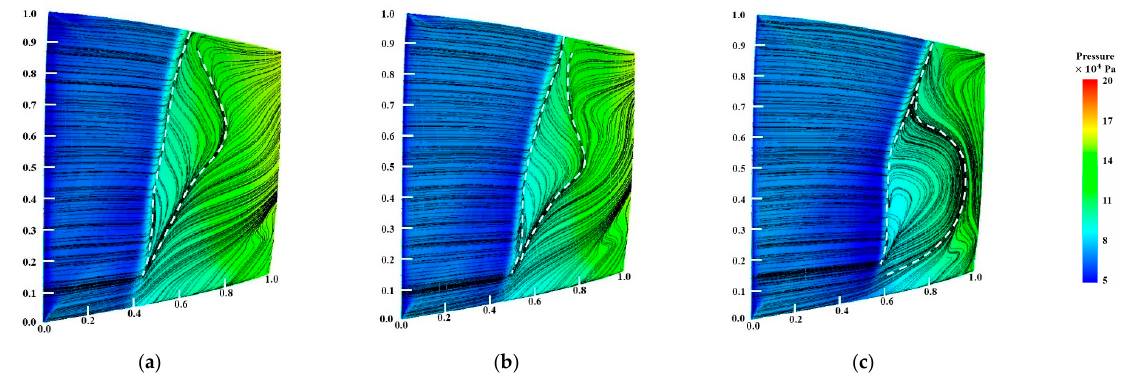
Figure 5. Pressure maps and the limiting streamlines on the blade suction side at ( a ) NS condition, SS, ( b ) Design condition, SS, ( c ) NC condition, SS.